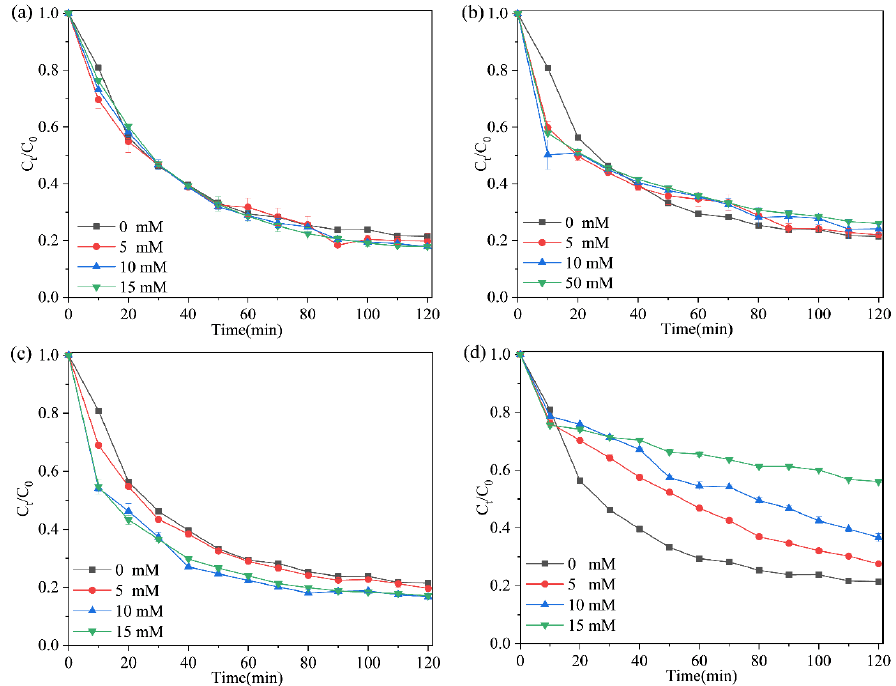
Figure 6. Effect of the anions in water (ranging from 0 mM to 15 mM) on TCH removal efficiency. ( a ) Cl − ; ( b ) HCO 3 − ; ( c ) NO 3 − ; ( d ) HPO 4 2− . Experimental conditions: IO@ESBC dosage of 1.25 g/L, the original PS concentration of 10 mmol/L, TCH dosage of 50 mg/L, initial pH, and temperature of 25 °C.